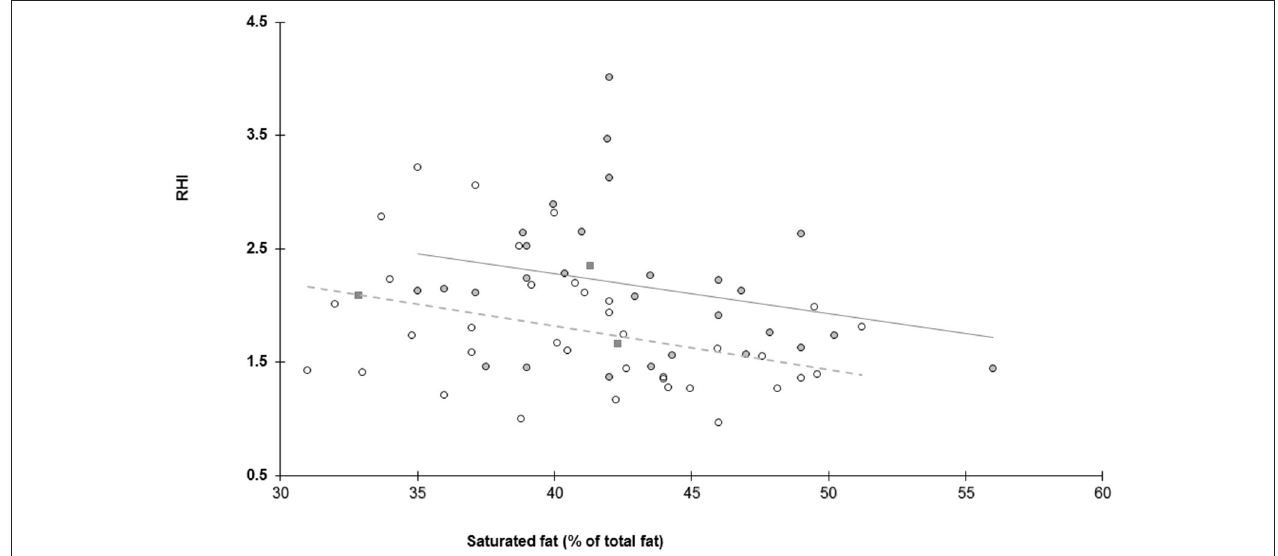
FIGURE 2 | Relationship between endothelial function assessed as reactive hyperaemia index (RHI) and habitual consumption of saturated fat expressed as percentage of saturated fat/total fat. Dark circles and solid line represent individuals of European background, open circles and dashed line represent individuals with an Asian background and dark squares represent